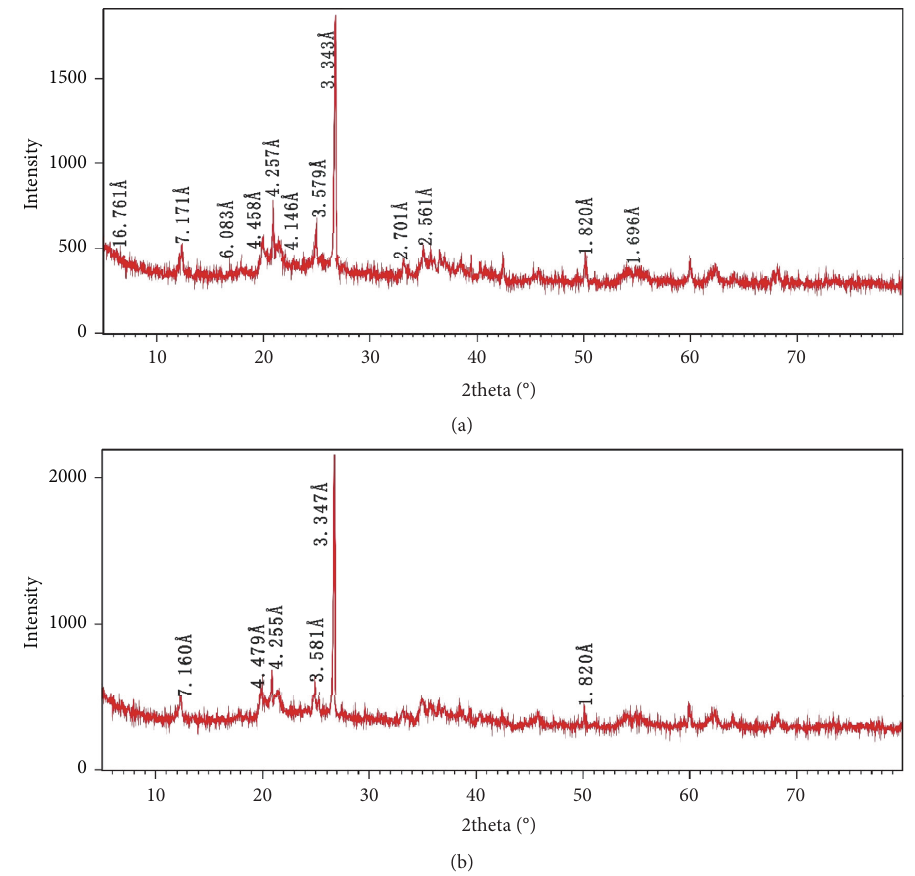
Figure 5: X-ray diffraction spectrum. (a) The x-ray diffraction pattern of red clay. (b) The x-ray diffraction pattern of red clay with a zinc ion concentration of